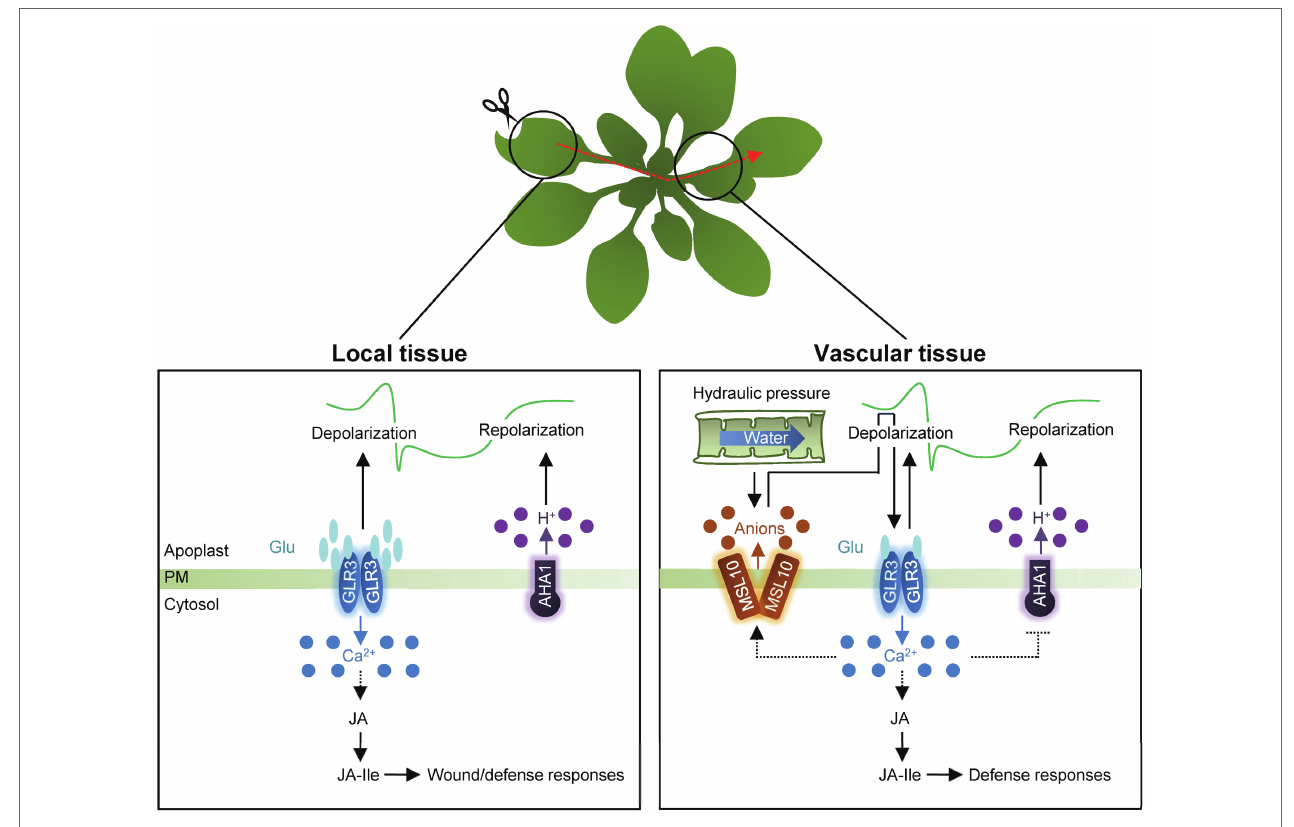
FIGURE 2 | Schematic representation of electrical signaling in local and systemic tissues. In local tissue, wounding triggers an increase in apoplastic Glu concentration and then, induces GLR-dependent Ca 2+ influx as well as depolarization of membrane potential. The GLR proteins likely act as tetramers. Following depolarization, H + -ATPase AHA1 is then required for membrane repolarization. The electrical signals systemically propagate through vasculature tissues in a connection with Ca 2+ wave. Changes in turgor pressure affect membrane tension and activate the heptameric anion channel, MSL10, causing membrane depolarization through anion efflux. The membrane depolarization fully activates GLRs in response to wounding. GLR-dependent Ca 2+ influx potentially causes activation of MSL10, simultaneously with the deactivation of AHA1. Synergistic propagation of Ca 2+ waves and SWPs promotes JA biosynthesis to induce defense responses in systemic tissues. PM, plasma